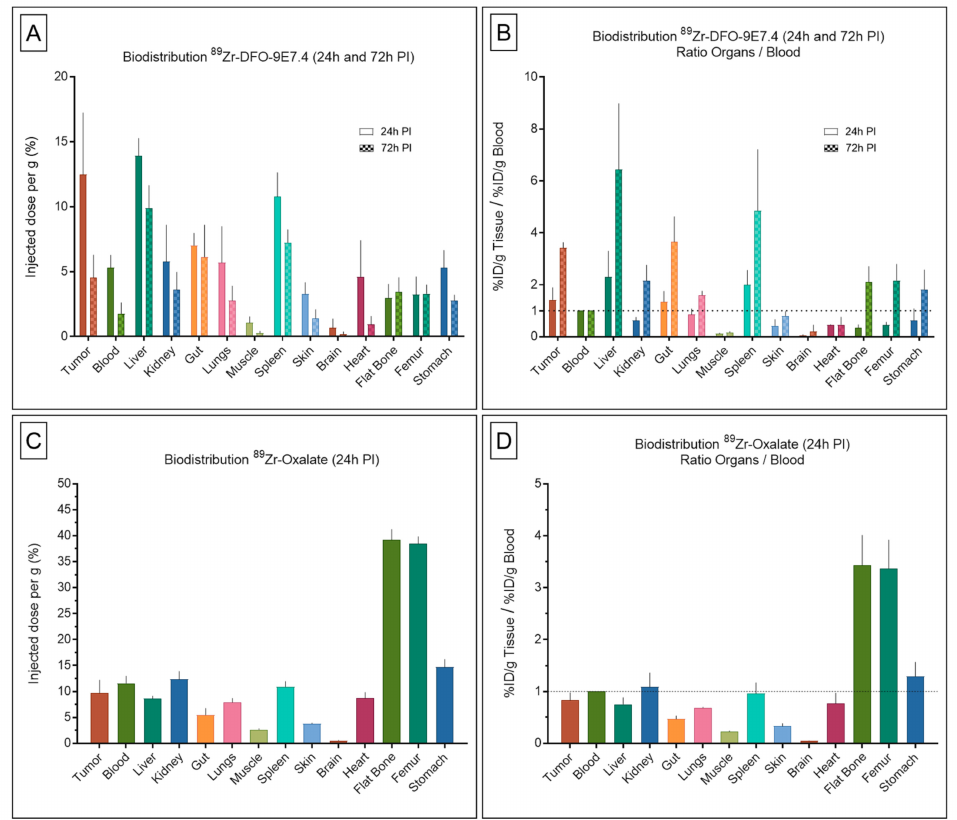
Figure1. Biodistributionresultsandorgan-to-bloodratiosof 89 Zr-DFO-9E7.4, 89 Zr-oxalateintumor-bearing mice. Ex vivo biodistribution results ( A ) and organ-to-blood ratios ( B ) of 89 Zr-DFO-9E7.4 at 24 h and 72 h post-injection (PI), in the subcutaneous tumor model ( n = 3 for each group). Ex vivo biodistribution results ( C ) and organ-to-blood ratios ( D ) of 89 Zr-oxalate at 24 h PI ( n = 3). Values are expressed in percentage of the injected radioactive dose per gram of tissue (%ID / g) and presented as mean ± SD.